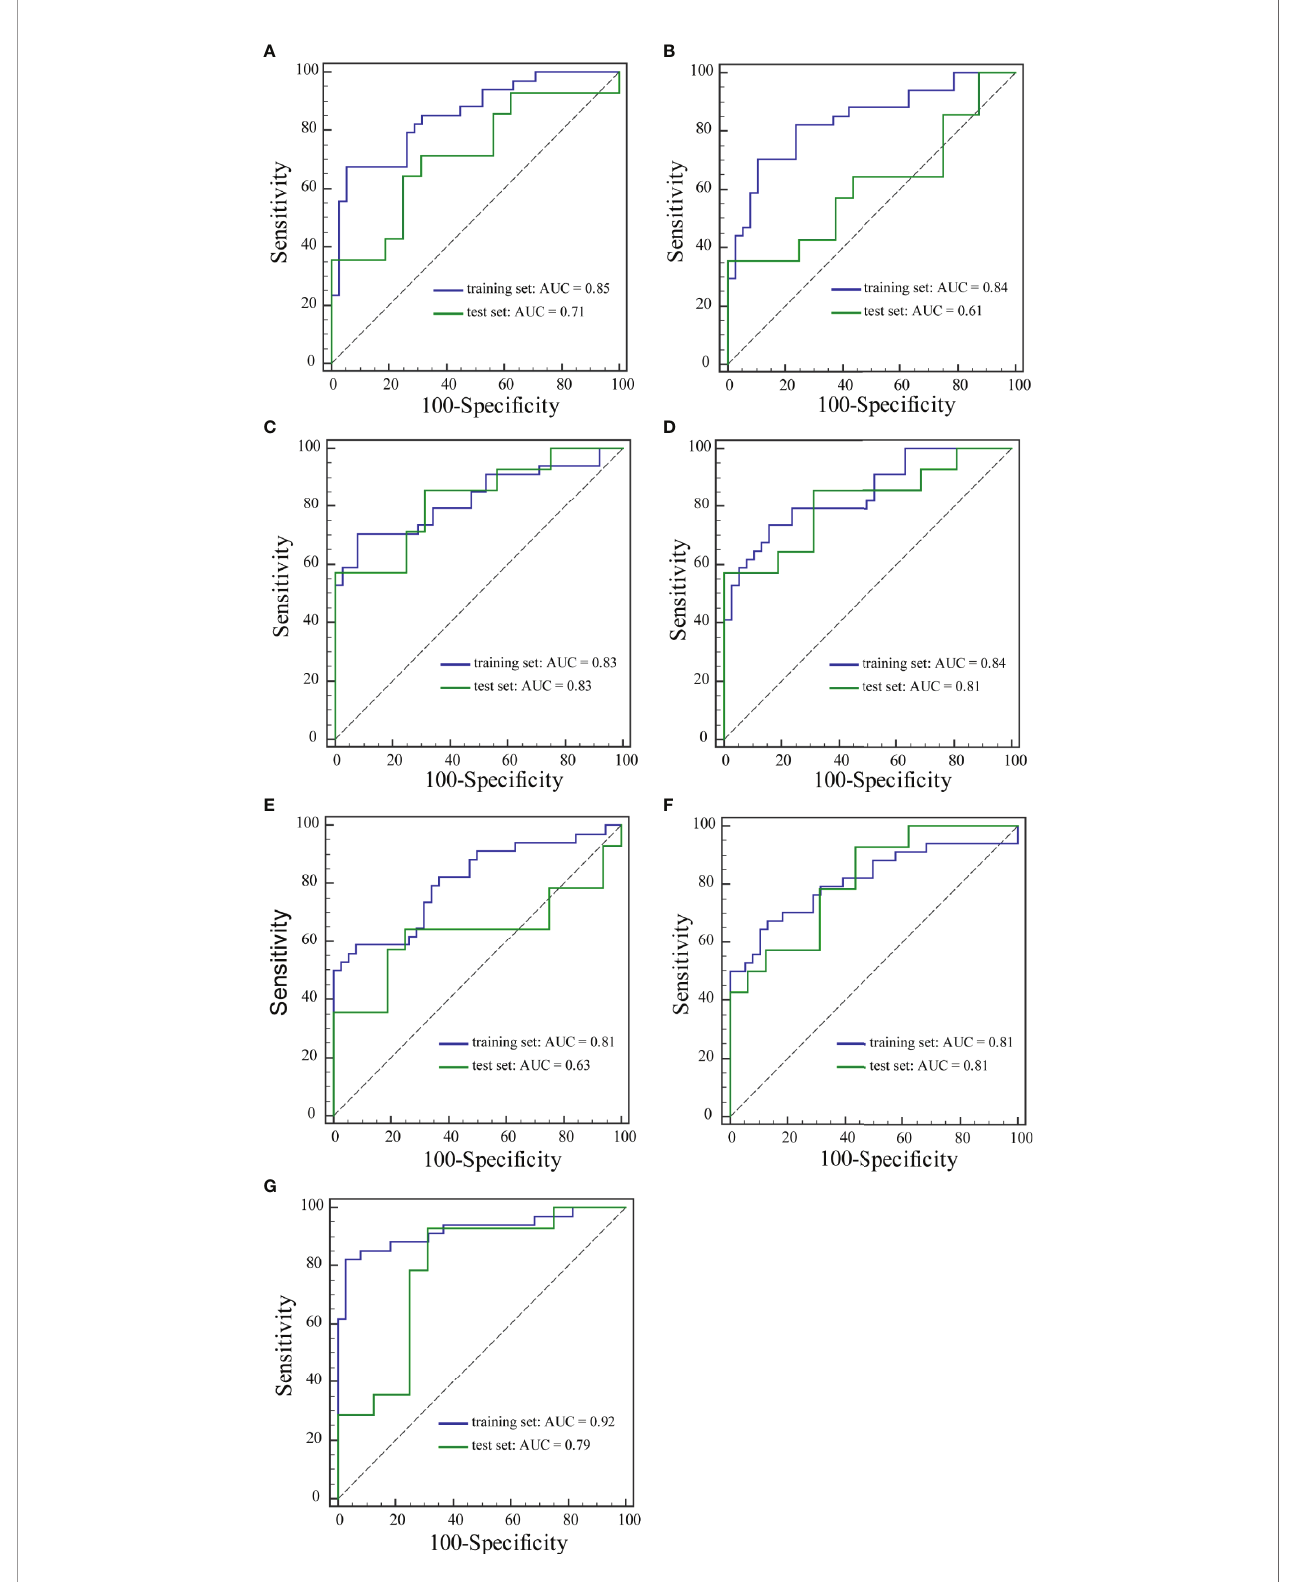
FIGURE 3 | ROC curves of the training set and the test set from Einitial (A) , Epeak (B) , ESER (C) , MSI (D) , SEP (E) , SER (F) , and SIslope (G)